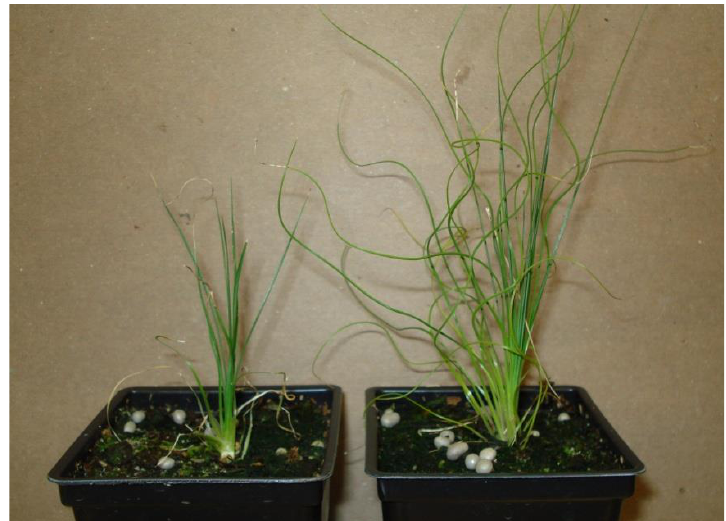
Figure 4. Shoots from isolated embryos from seed source 5 germinated in vitro and transferred to greenhouse soil under domes. Until two months plants grew well, but after 3 months they damped off and died.